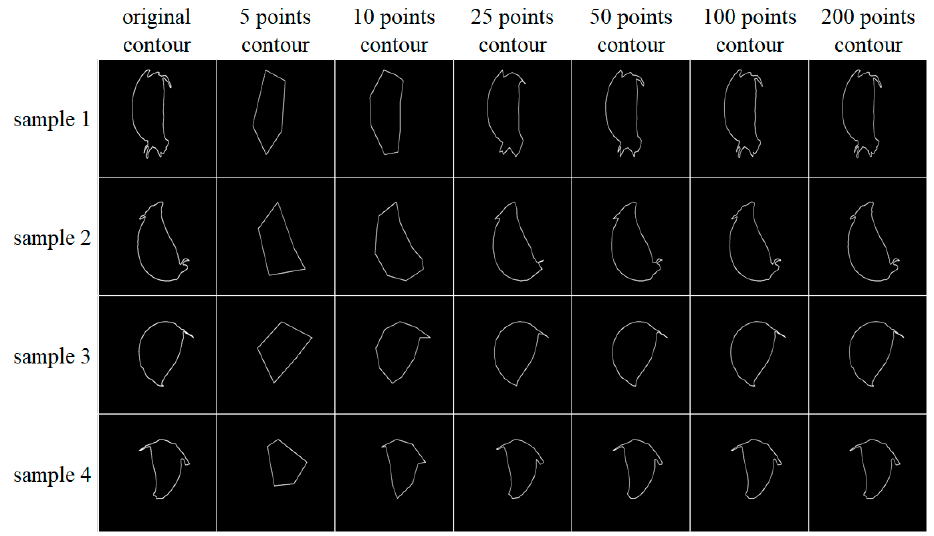
Figure 12. The ability of contour points with different sampling rates to restore the original contour. The matrix shape of the contour point set obtained by the findcontours function of OpenCV is [ n , 2], where n is the number of contour points, and the matrix shape of the contour point set after sampling is [ m , 2], where m is the number of sampling points, and the dimension with length of 2 contains the horizontal and vertical coordinates of each contour point. For the fully connected model discussed in this section, the input of each layer of the model should be a one-dimensional vector, so it is necessary to flatten